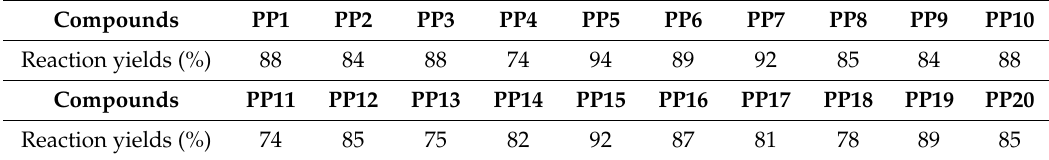
Figure 3. Synthetic pathways to PP1 – PP20 and the ten aldehydes used in this study. Table 1. Reaction yields obtained for the synthesis of PP1 – PP20 .